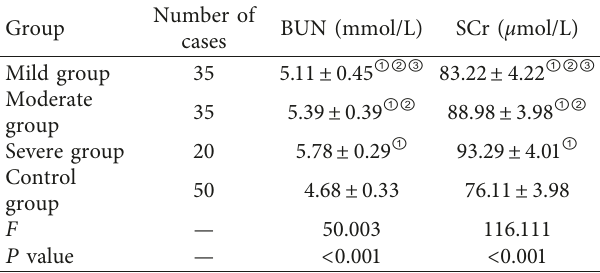
Table 2: Comparison of renal function indicators among patients in each group ( x ± s